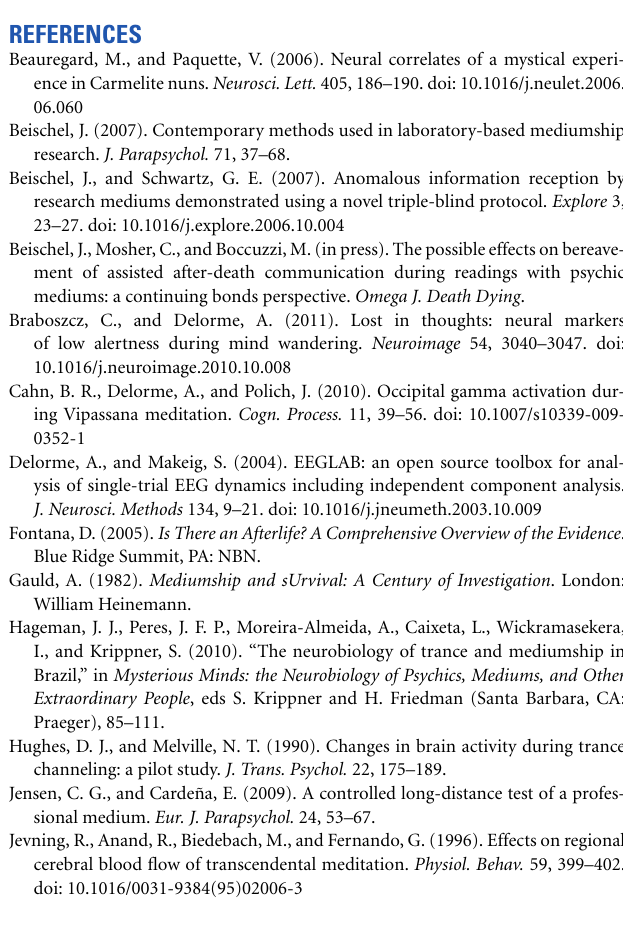
Figure S1 | Correlation between alpha power (8–10Hz) and for the accuracy of statements reported by Medium 3. Legend same as for Figure 2A . Figure S2 | This figure is similar to Figure 3 but instead of processing the data, we processed artifacts as isolated by independent component analysis. Figure S3 | Grand average spectrum for three participants that showed significant differences between mental states [the unit being 10 * log 10 ( µ V 2 )]. The ANOVA method was used to compute significance. Electrodes in white indicate those deemed significant after correction for multiple comparison and across all mental